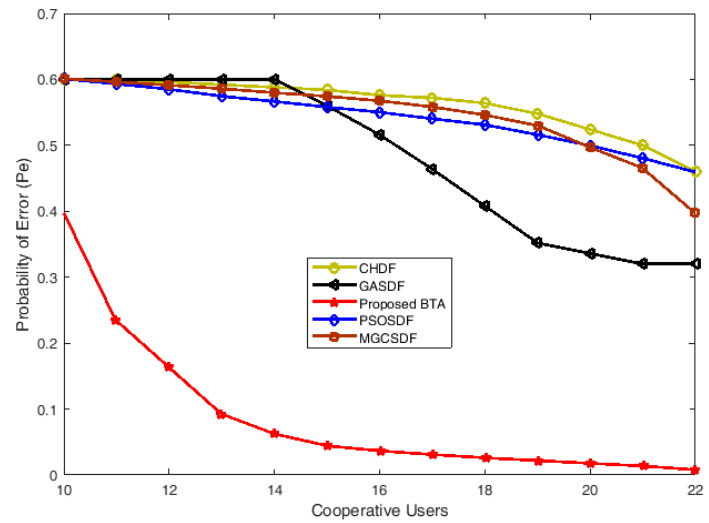
Figure 8. Probability of error vs. cooperative users with no category of MUs.